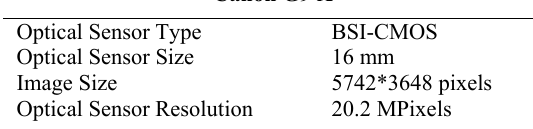
Table 1. Technical specifications of the photographic sensor